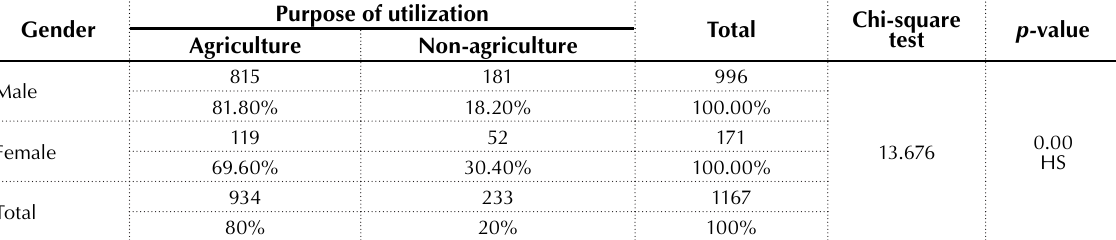
Table 2. Impact of gender on the purpose of agricultural credit